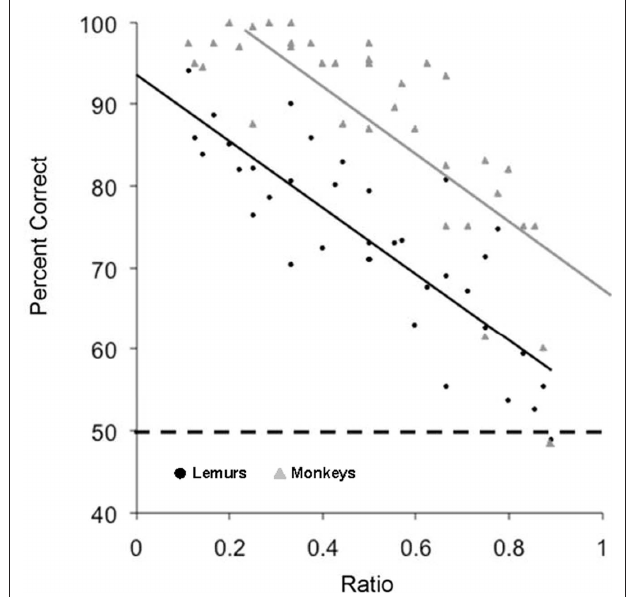
Figure 7 | Lemur accuracy (black circles) for experiment 2B as a function of the numerical ratio between the values being compared. Monkey data (gray triangles) from Brannon and Terrace (2000) is plotted for comparison. The regression slopes for the two species are highly similar (lemurs: y = − 40.57 x + 93.69; monkeys: y = − 41.31 x + 108.6). The dotted line indicates chance for the task.